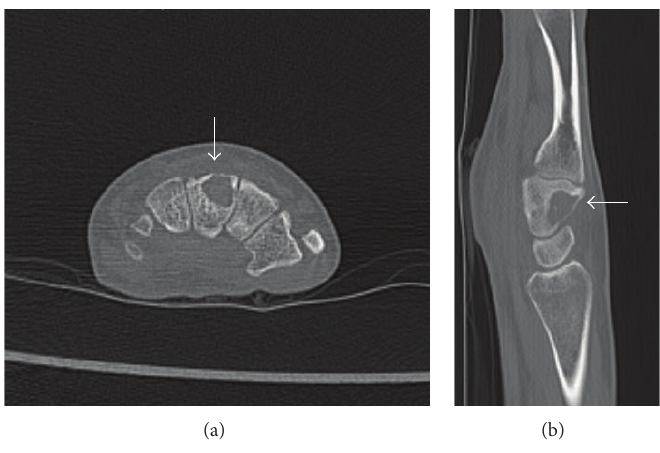
Figure 1: CT images of the patients. Cystic lesion with sclerotic margin is seen in axial plane and sagittal plane ((a) and (b), resp.). White arrows are showing the cystic lesion.